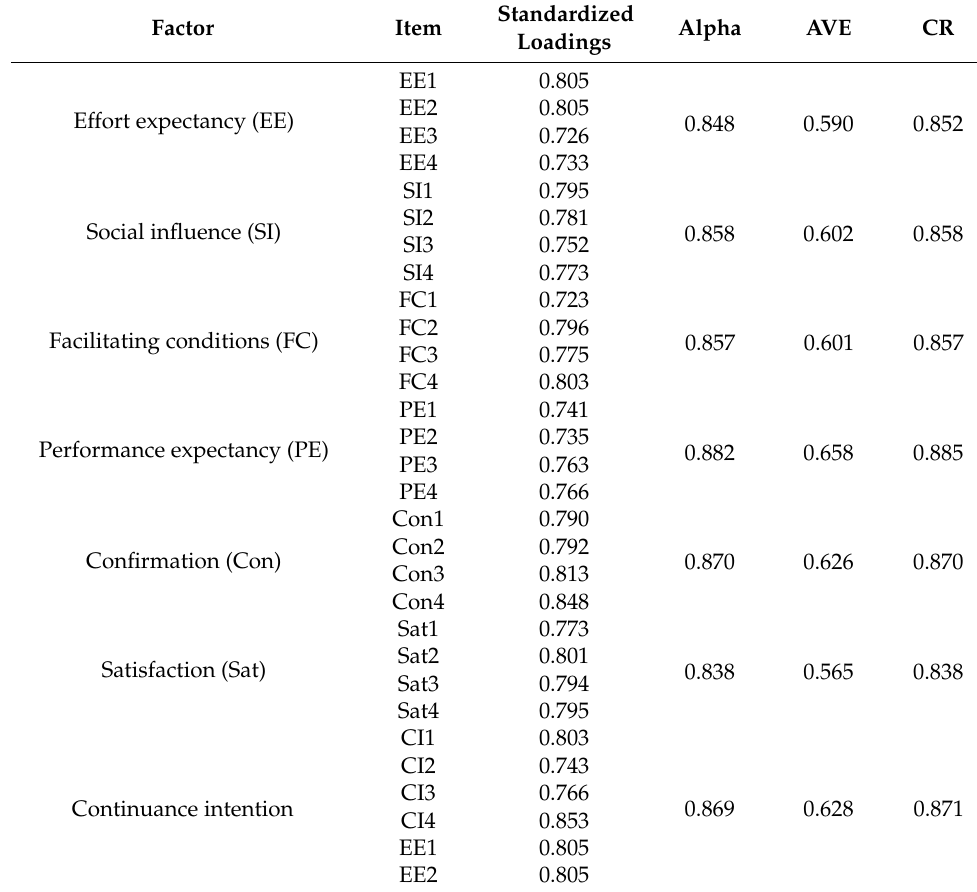
Table 2. Standardized item loadings, CR, AVE and alpha